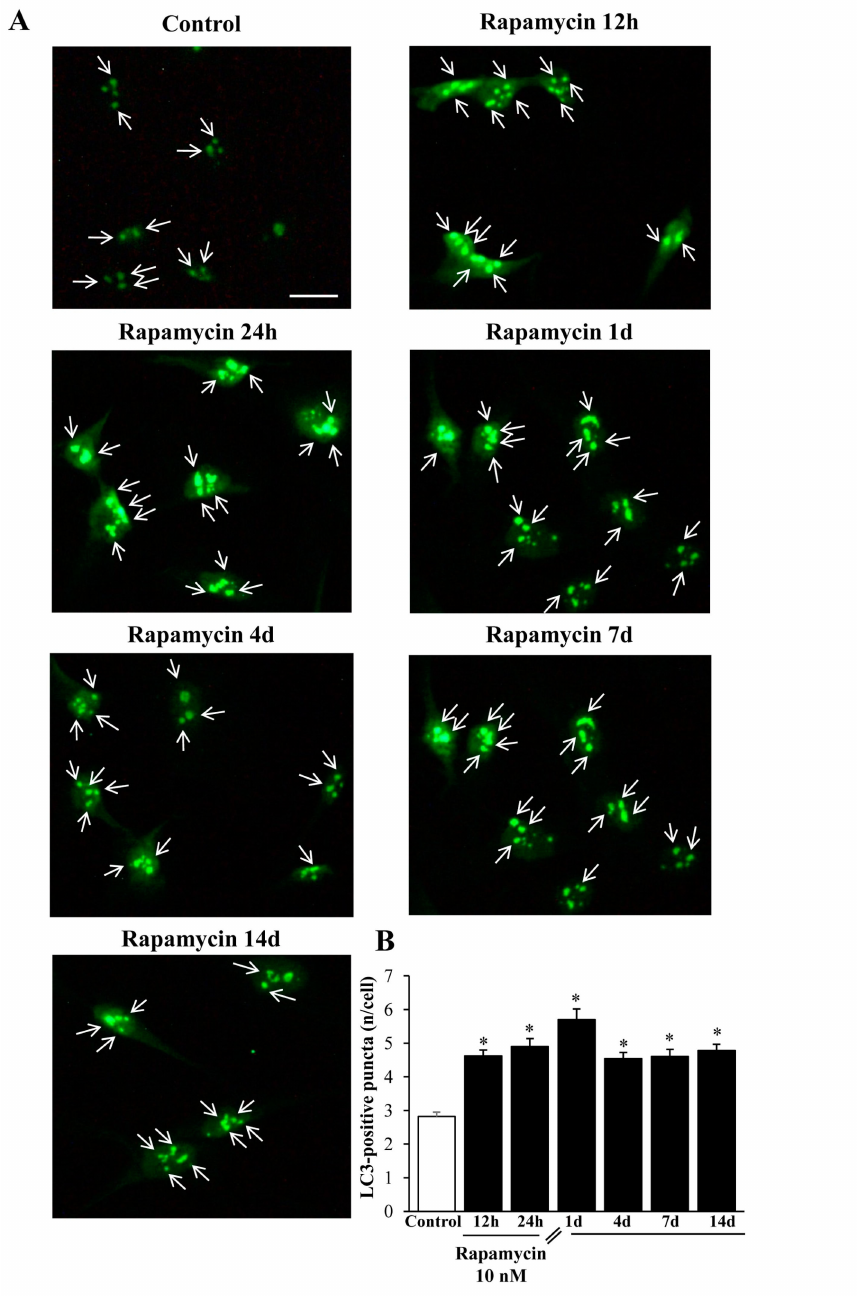
Figure 15. Rapamycin increases the immunofluorescence of LC3 within A172 cells. ( A ) Representative immunofluorescence from A172 cells. While arrows point to LC3 puncta (green). ( B ) Graph reports the number of LC3 puncta per cell. Values were obtained from 100 cells per group. * p ≤ 0.05 vs. Control. Scale bar: 25 µ